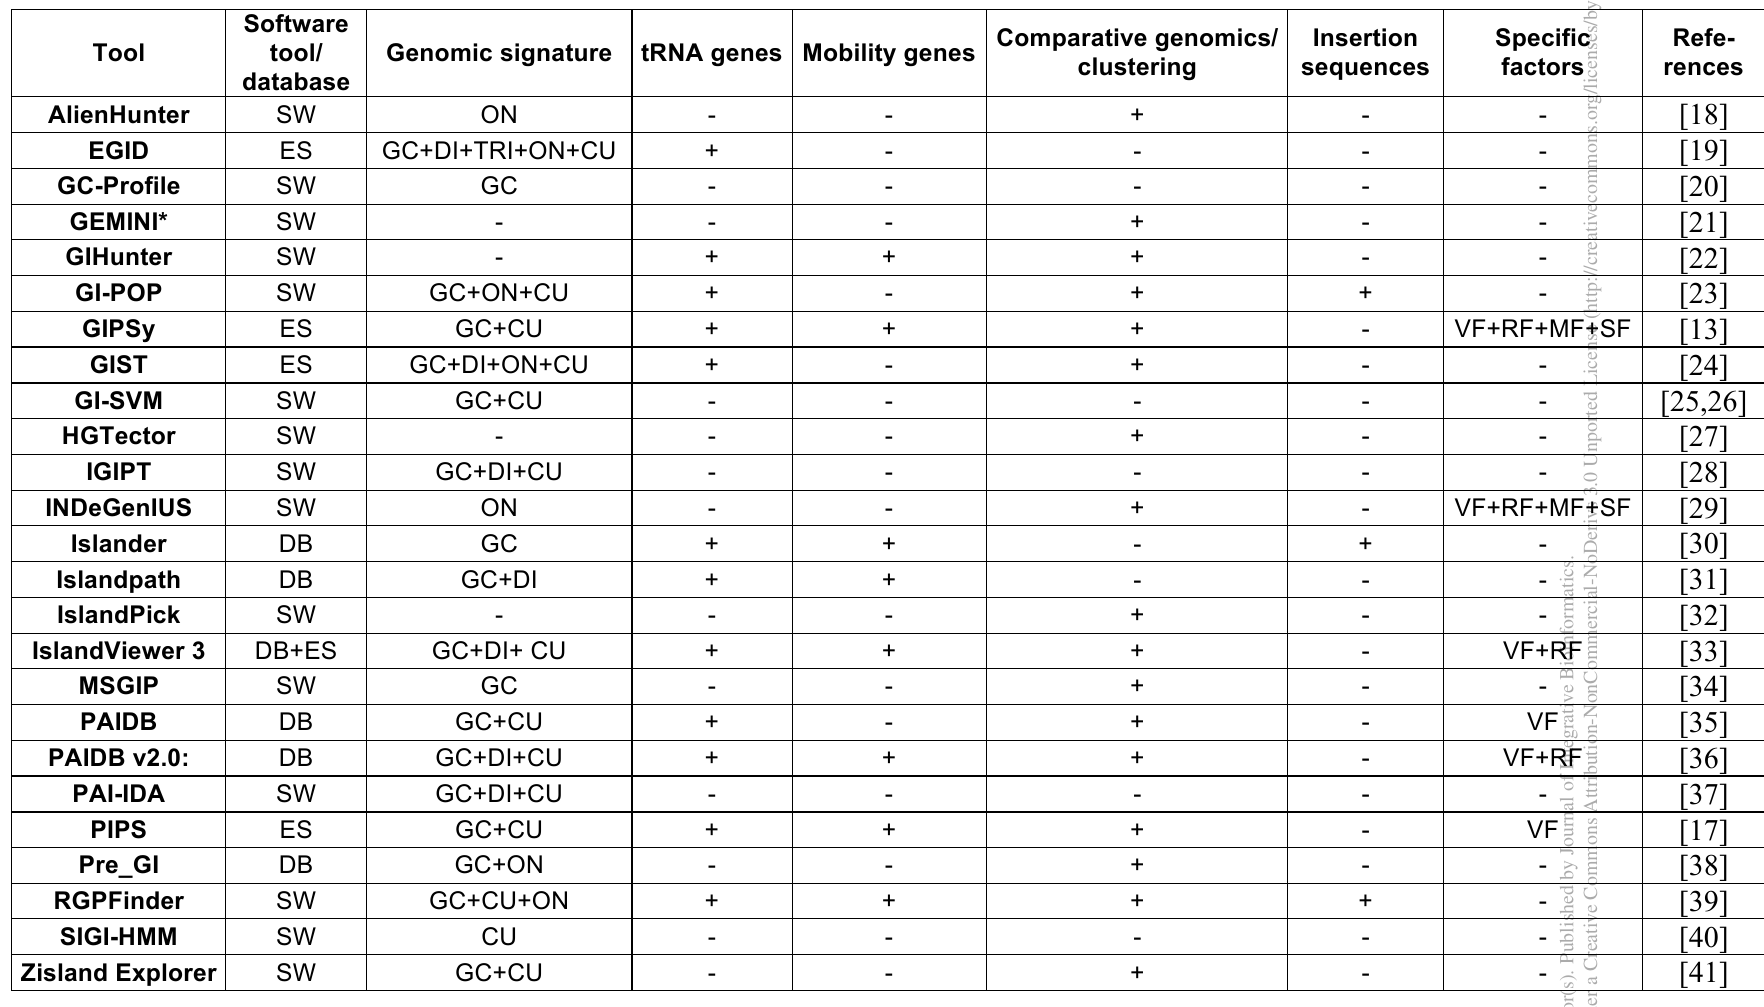
Table 1: GI prediction tools and their